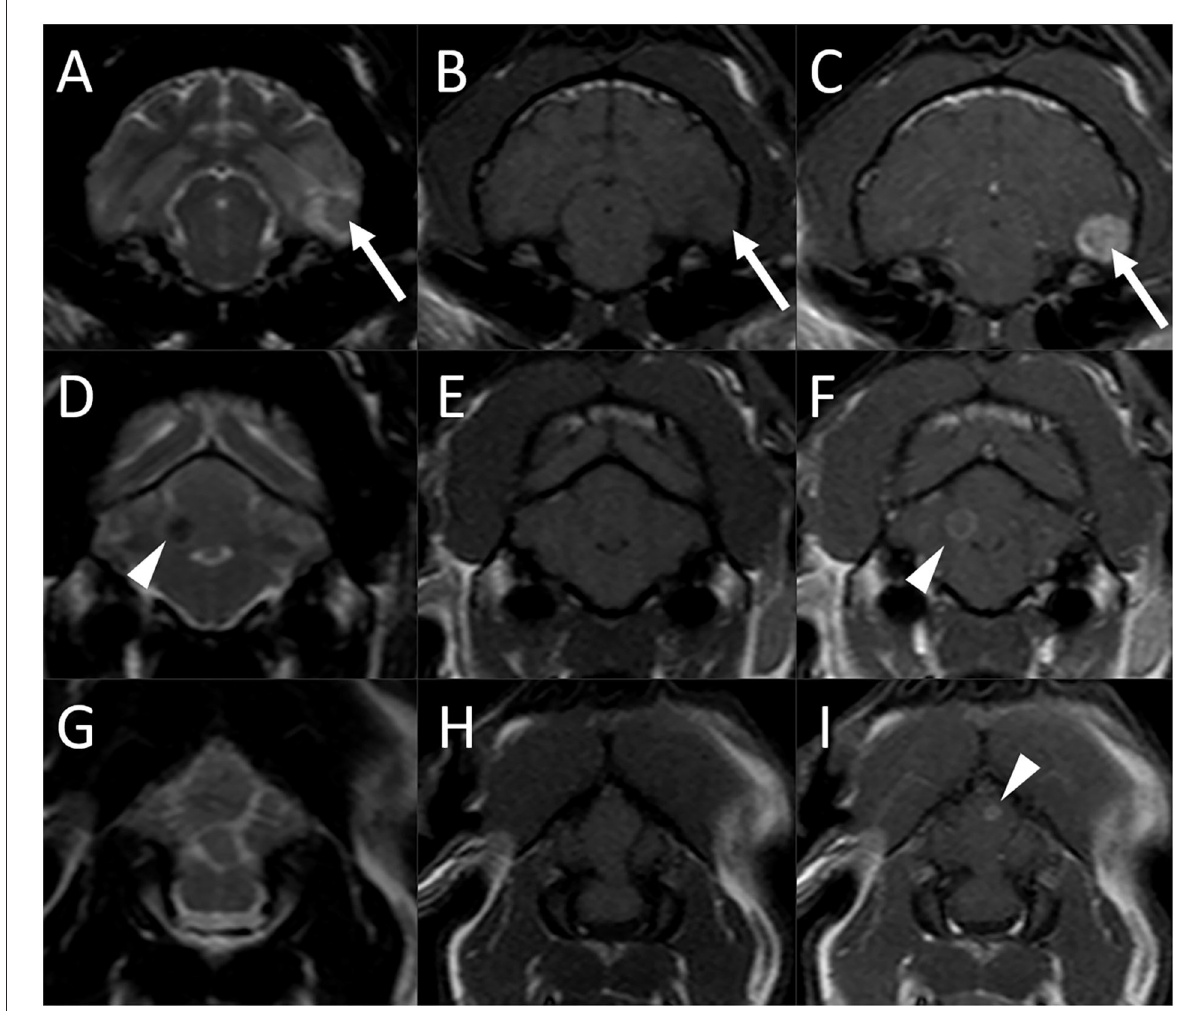
FIGURE1 Brain MRI in an 11-year-old male castrated domestic shorthair cat (Case 1) 3 months after the diagnosis of systemic blastomycosis and after experiencing two seizures after the latest antifungal treatment. Transverse T2-weighted (A) , (D) , and (G) , T1-weighted (B) , (E) , and (H) , and postcontrast T1-weighted (C) , (F) , and (I) images. (A)–(C) A round ≈ 0.8-cm diameter nodule is associated with the ventral aspect of the left temporal lobe (arrows) which is iso-to slightly hypointense to gray matter, with a hyperintense rim on T2-weighted image (A) , slightly hypointense on T1-weighted image (B) , and has strong and homogeneous contrast enhancement (C) . There is moderate indistinct perilesional T2 hyperintensity, consistent with perilesional edema. (D)–(E) A second well-circumscribed ≈ 0.4-cm diameter T2 hypointense (A) and T1 isointense (B) lesion is associated with the right cerebellar hemisphere and exhibits moderate ring enhancement (C) following contrast medium administration (arrowheads). (G)–(I) A third ≈ 0.2-cm diameter ring-enhancing lesion is noted in the cerebellar vermis [ (I) , arrowhead], not seen on the precontrast